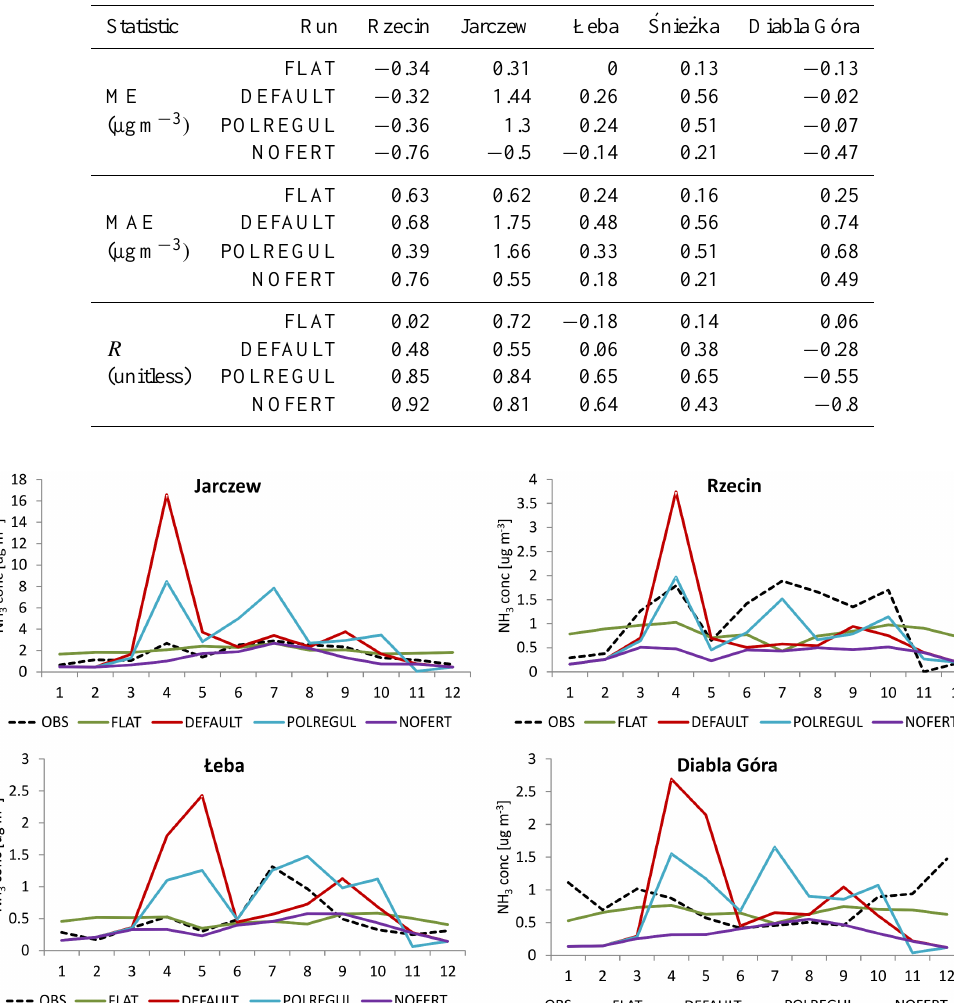
Figure 6. Time series of modelled and measured NH 3 concentrations for